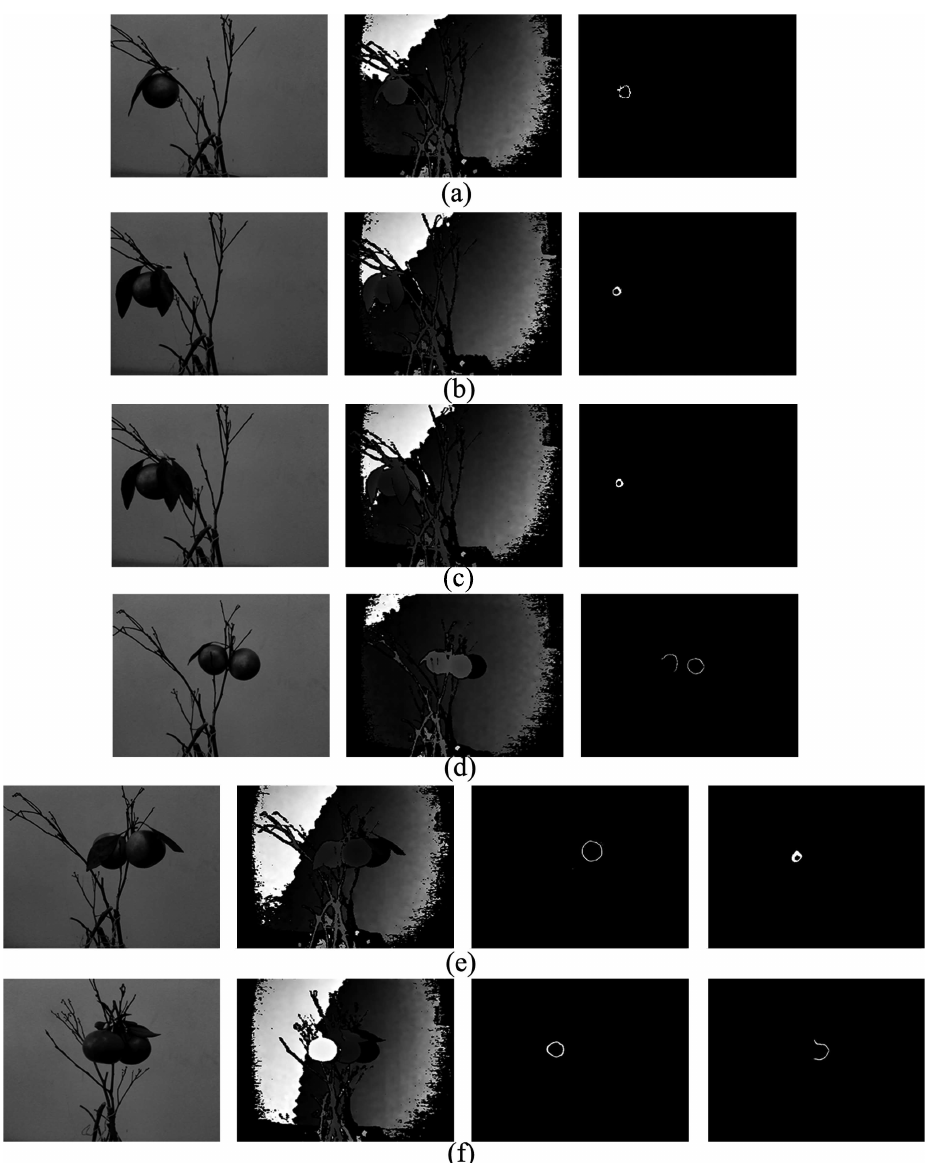
Figure 17. Successful fruit intersection curves of the experiment of different fruit-leave collocations: ( a ) one fruit and one leaf; ( b ) one fruit and two leaves; ( c ) one fruit and multiple leaves; ( d ) two fruits and one leaf; ( e ) two fruits and two leaves; ( f ) two fruits and multiple